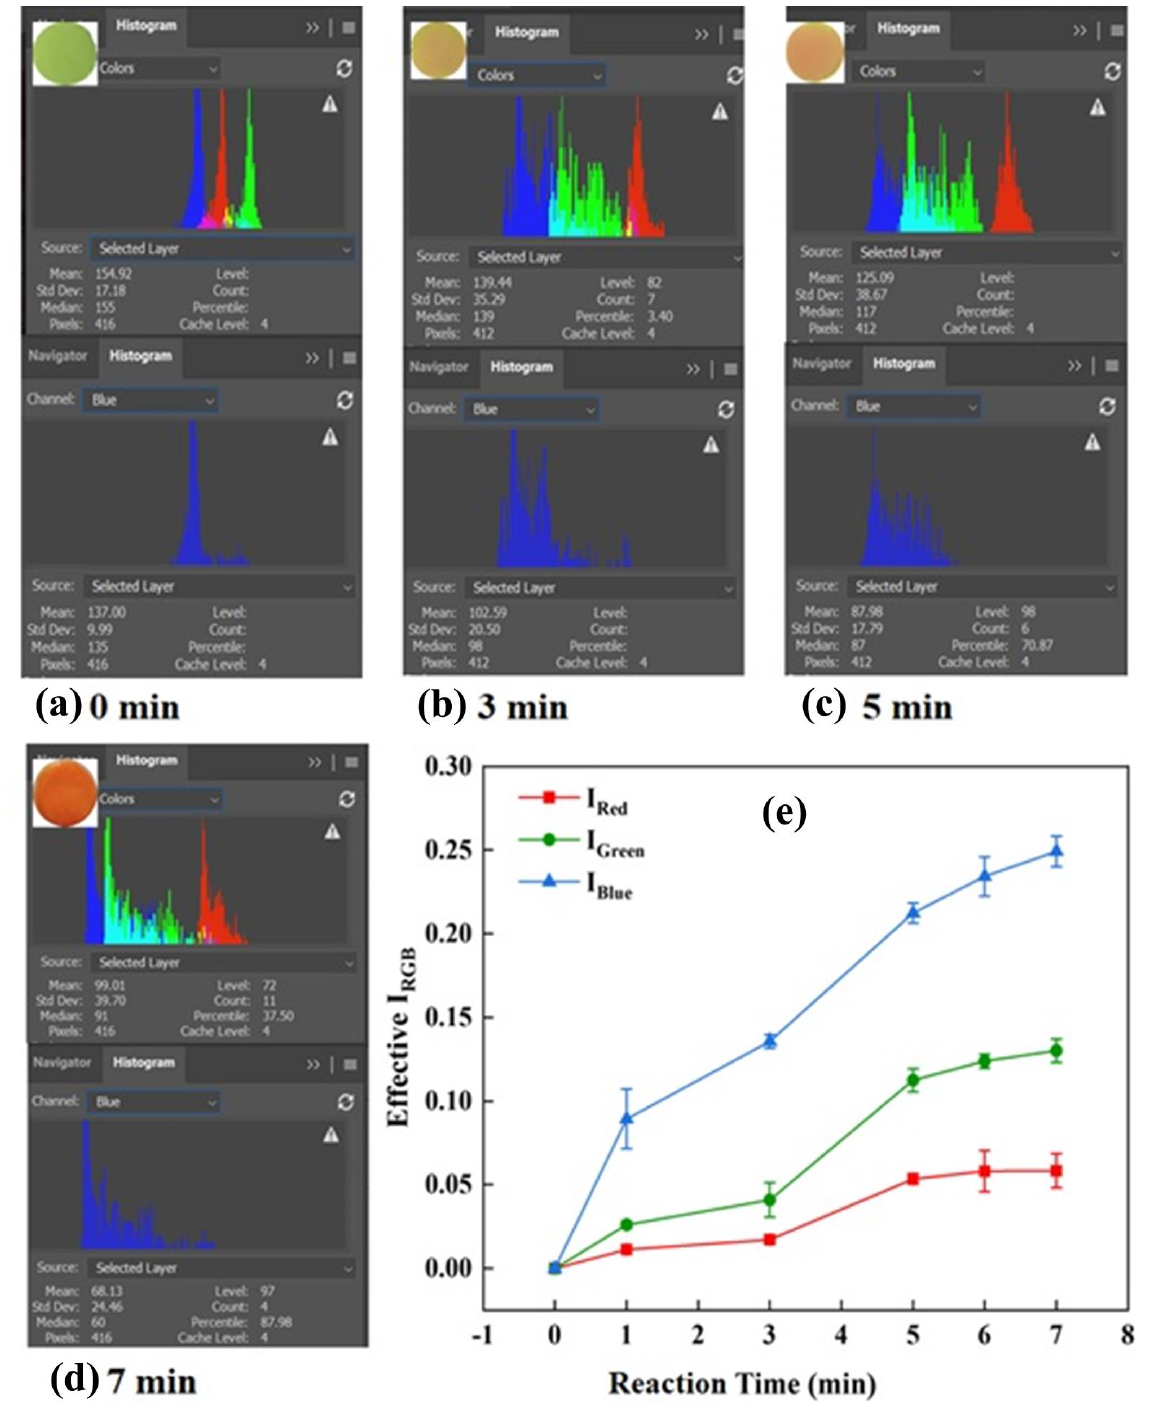
Figure 2. ( a – d ) Histogram showing the change in color intensity along with the real image of disc showing real–time color change; and ( e ) Representation of change in color intensity of all the three standards through RGB analysis, i.e., Effective I Red, Effective I Green, and Effective I Blue ; symbols and bars represent the average and standard errors of the data ( n = 3), respectively.